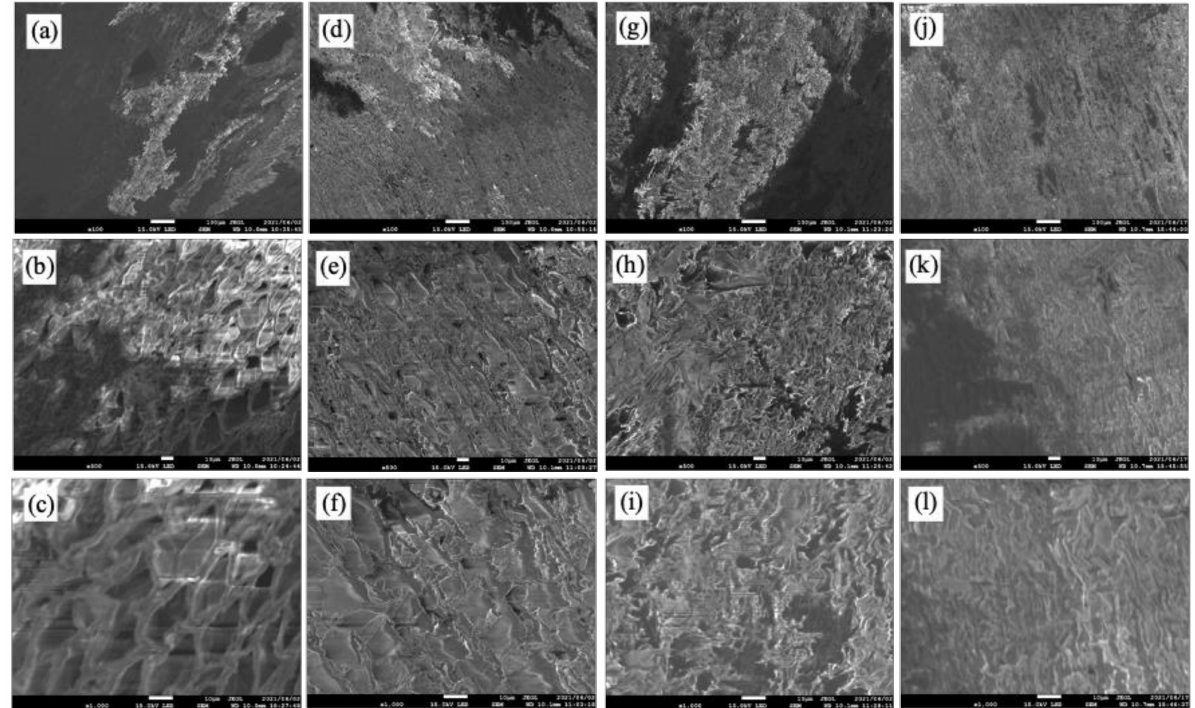
Figure 9. SEM micrographs: control ( a ) 100 µ m, ( b ) 500 µ m, ( c ) 1000 µ m; 100 ◦ C ( d ) 100 µ